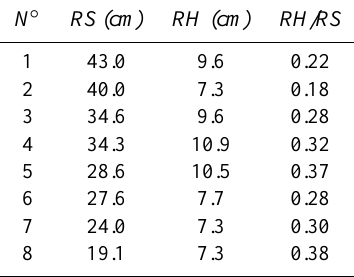
Table 1. Characteristics (spacing: RS ; height: RH ) of ridges for each experimental